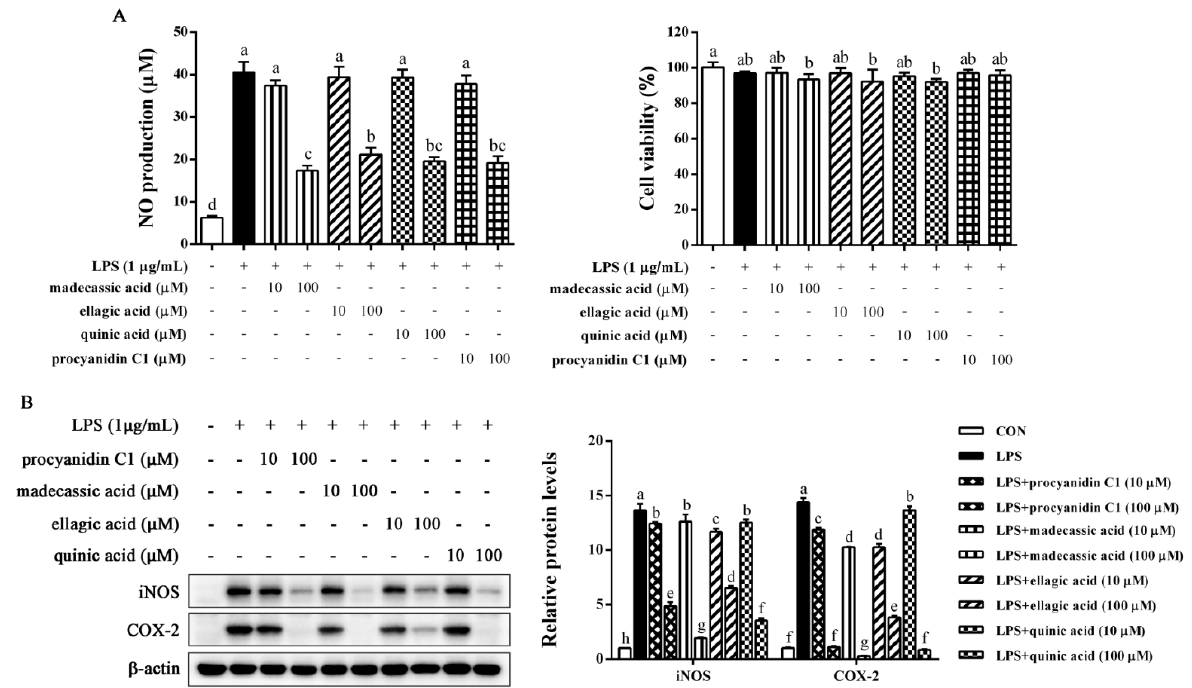
Figure 7. Inhibitory effect of major compounds in EFR on LPS-induced inflammatory responses in RAW 264.7 macrophages. RAW 264.7 macrophages were pretreated with madecassic acid, ellagic acid, quinic acid, and procyanidin C1 (10 and 100 μ M) for 2 h and then stimulated with or without LPS (1 μg/mL) for 24 h. ( A ) The nitrite concentration in the cultured media was determined as an indicator of NO production by Griess reaction. ( B ) The protein levels of iNOS and COX-2 were determined by Western blot analysis. β -actin was used as an endogenous control. Relative intensity of the immunoreactive bands was analyzed using the Image J software. Results are shown as the mean ± SD of three independent experiments. The different letters represent the statistical differences at p < 0.05 among the groups by Duncan’s multiple range test. Table 1. Identification of the top 20 components with relative abundance in EFR by LC–MS ( n = 3).